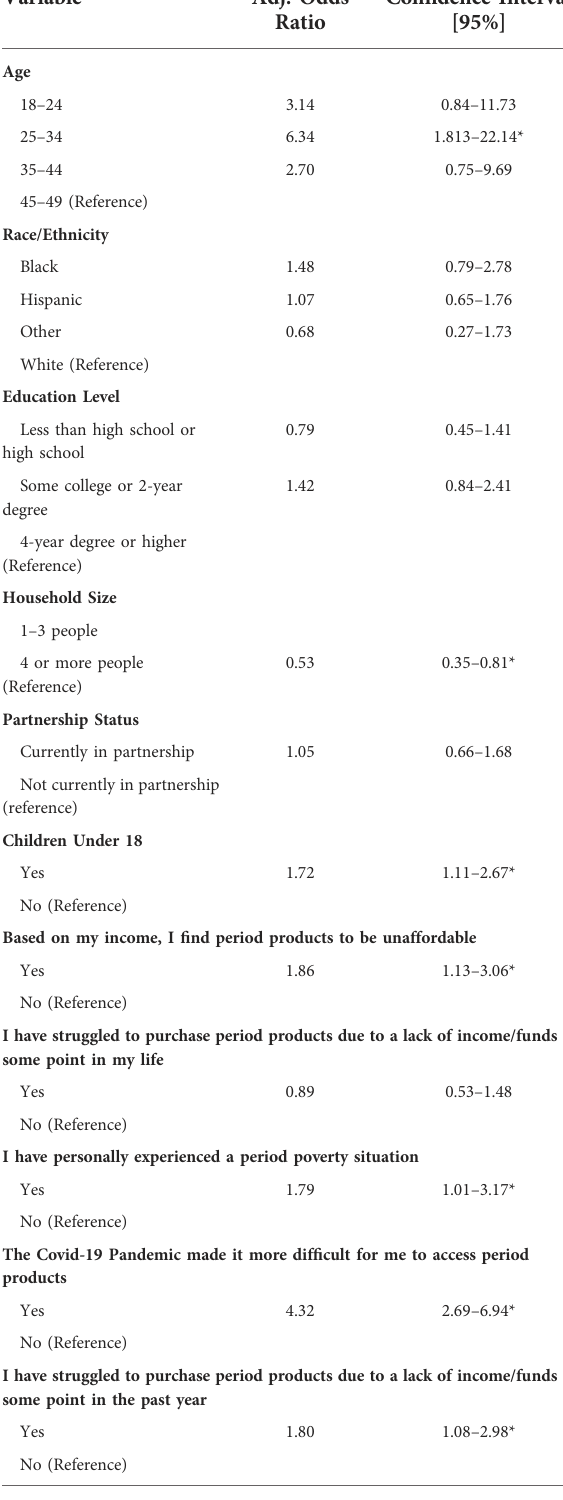
TABLE 5 Weighted logistic regression for predictors of missing work due to a lack of access to period products ( n =943).